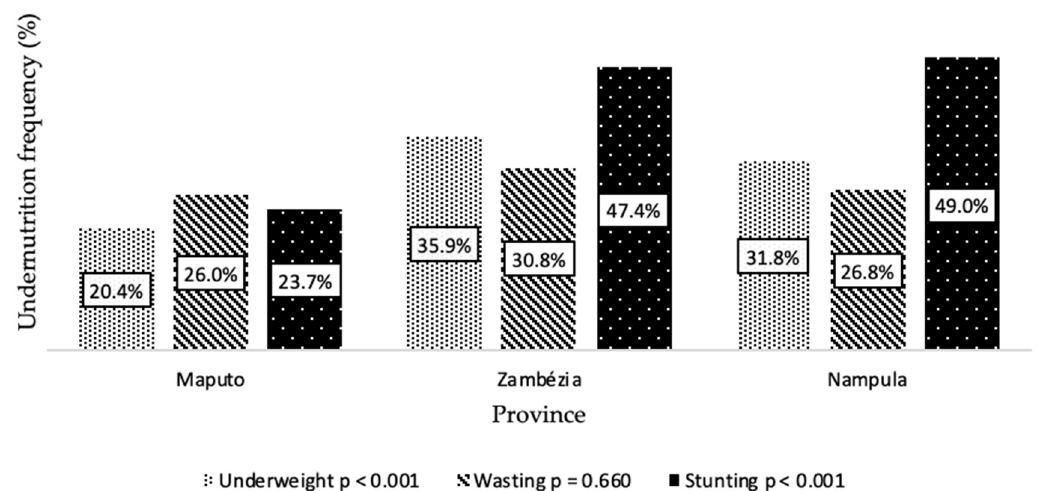
Figure 3. Frequency of different undernutrition status in children by provinces.